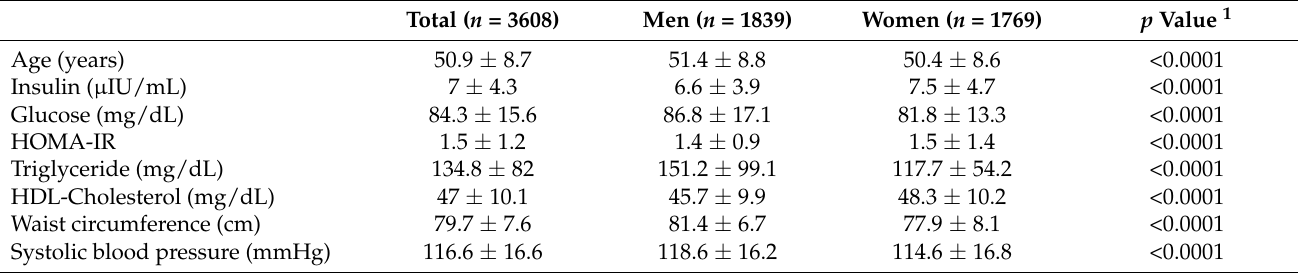
Table 1. Sociodemographic, clinical, lifestyle, and genetic characteristics of the study participants at